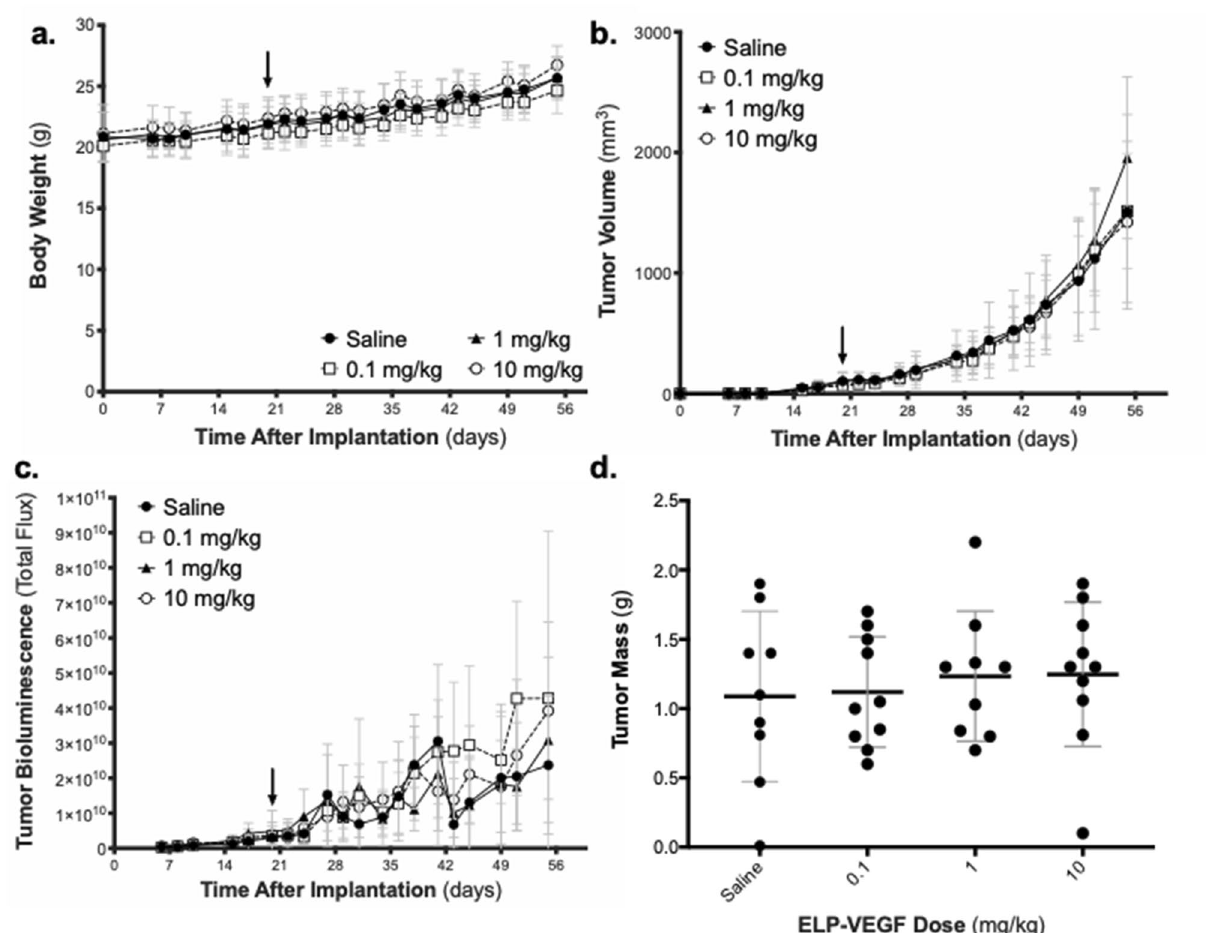
Figure 7. Effect of ELP-VEGF on Breast Tumor Progression. Body weight (a) , tumor volume (b) , and tumor bioluminescence (c) were tracked in nude mice bearing MDA-MB-231 triple negative breast tumor xenografts following a single IP bolus injection of ELP-VEGF (arrow). (d) Tumor mass was assessed at sacrifice five weeks after ELP-VEGF